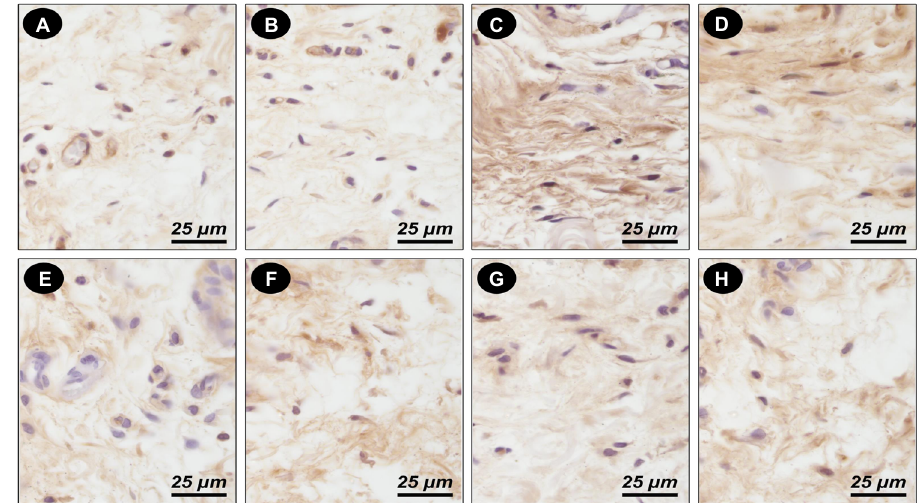
Fig. 3 Photomicrographs showing the immunoreactive cells (arrow- heads) for IL-6 ( A – D ); IL-17 ( E – H ) at 30 days for Control ( A , E ); Ambroxol-associated Propylene Glycol ( B , F ); Ambroxol-associated